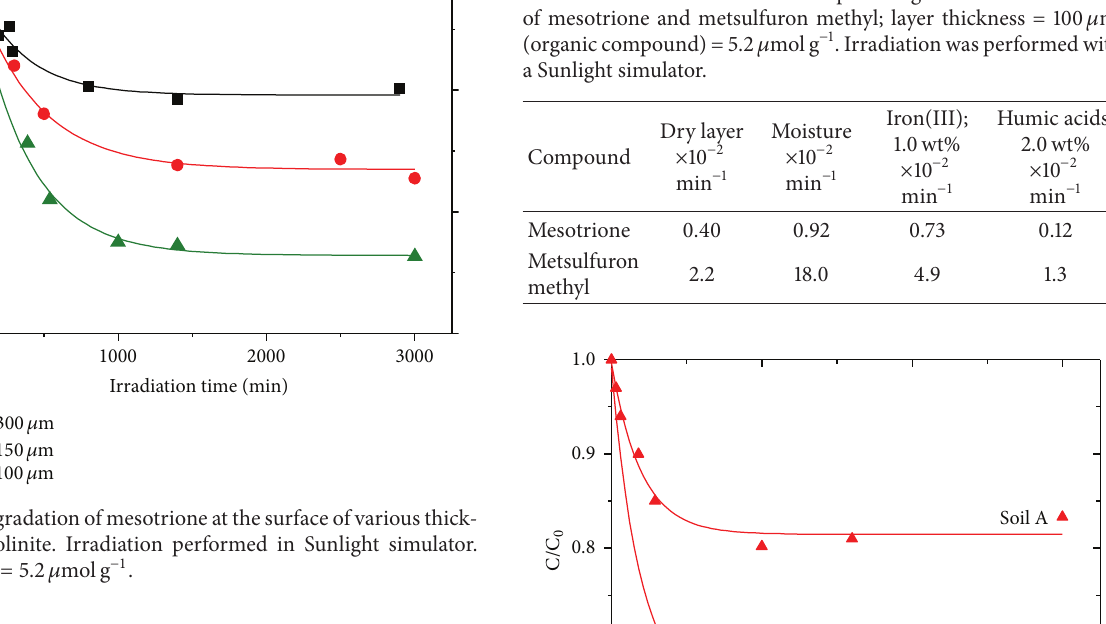
Table 2: The effect of moisture, iron(III), and humic substances at the surface of Kaolinite on the photodegradation rate constant of mesotrione and metsulfuron methyl; layer thickness = 100 𝜇 m; (organic compound) = 5.2 𝜇 molg − 1 . Irradiation was performed with